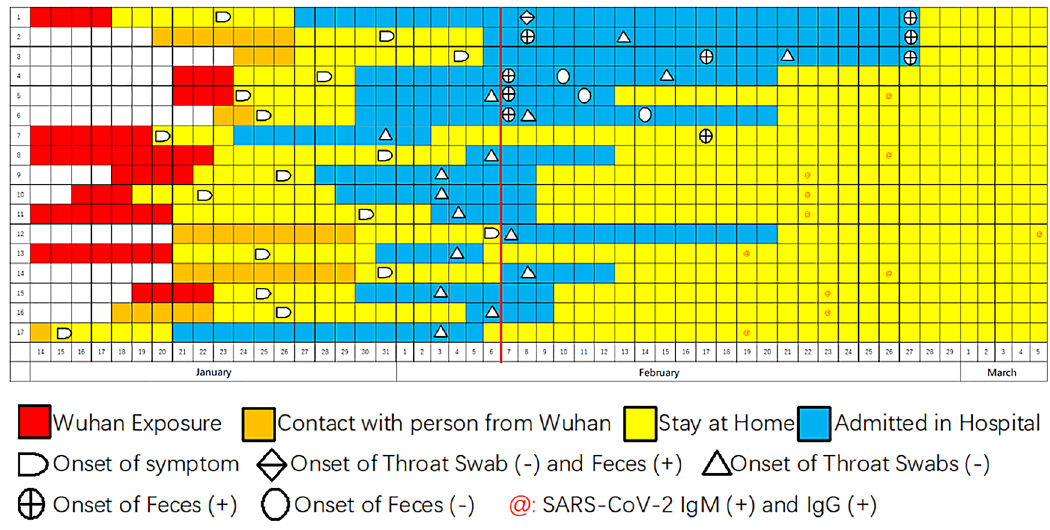
Figure 1: Summary of COVID-19 patient incubation periods and times of discharge and